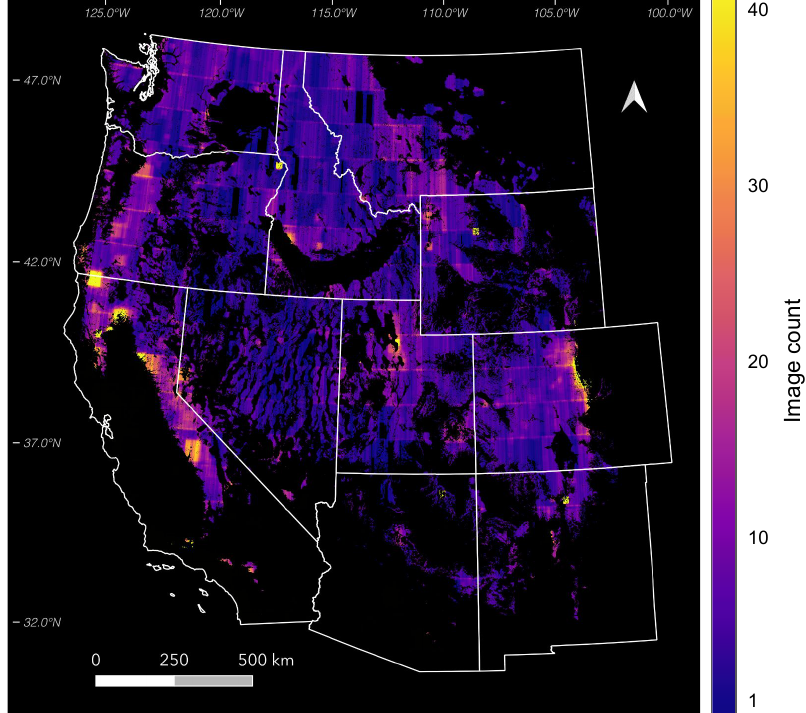
Figure 9. Heatmap showing multispectral WorldView-2 and WorldView-3 image coverage in the Maxar archive (<25% cloud cover) over the mountainous Western United States between 1 October and 1 June for the period spanning 2009 to 2020. A mask was applied to highlight coverage over mountains with seasonal snow, using data products from Wrzesien et al.